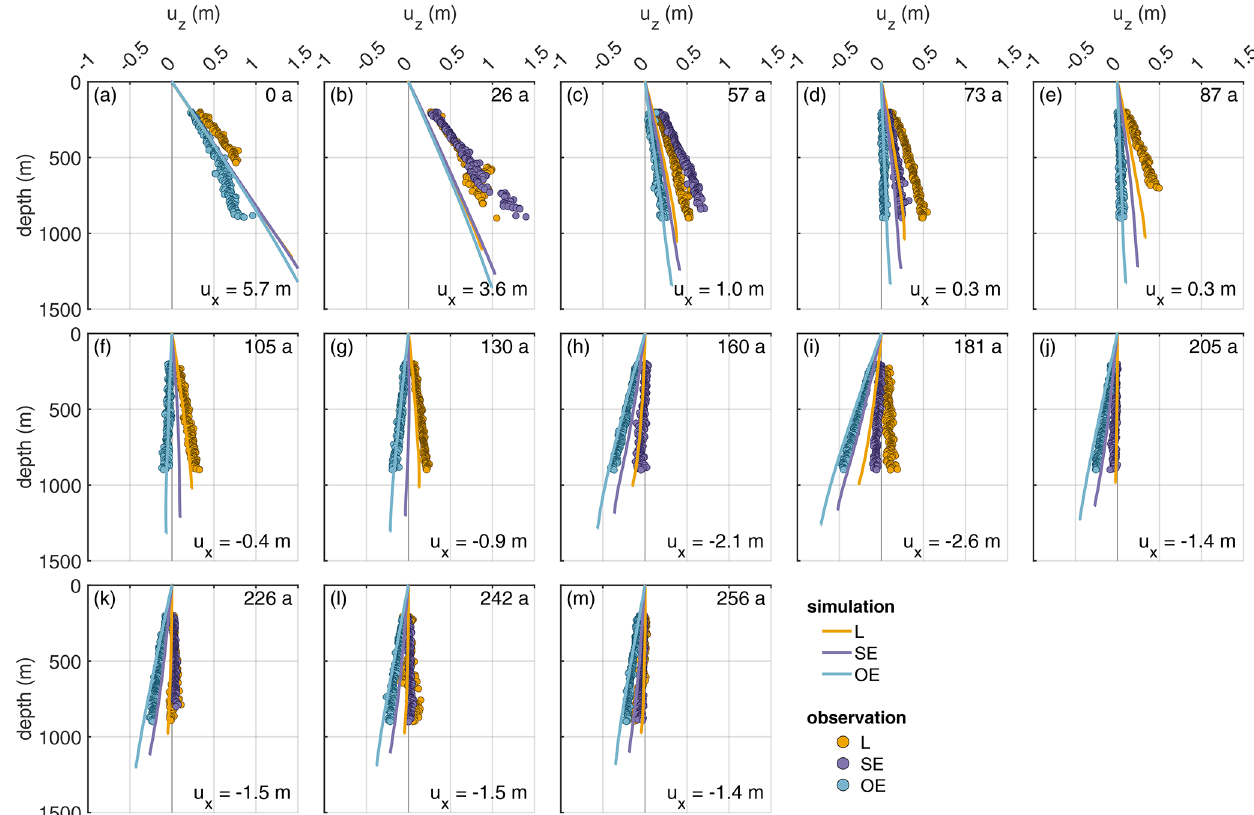
Figure 8. Second experiment: comparison of displacements ( u z ) derived from observations (dots) and the simulations (lines). The different panels show the displacement for (cid:49)t = 1 year allocated to the simulation time (upper right corner). The numbers in the lower right corners give horizontal displacement u x derived from ε zz of the pRES measurements outside the channel (OE), with positive values representing compression and negative values